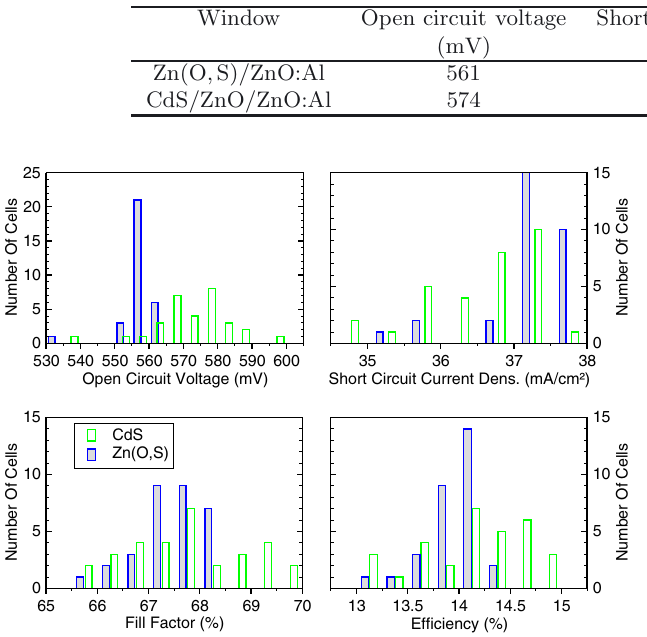
Table 2. Parameters of the best cells (in-house total area measurements under simulated AM 1.5 illumination, without AR coating).